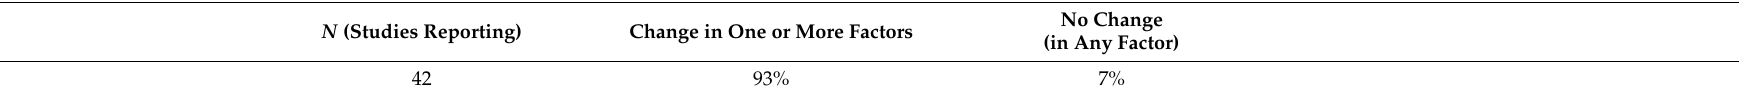
Table 3. Results of the meta-analysis of research studies ( N = 42) on the interactions of livelihood diversification with resource and ecological systems. This analysis drew from 42 published research papers that related the diversification of livelihood activities, with emphasis on migration, non-migration diversification of livelihoods, and the conditions of agrobiodiversity, soil and water resources, and uncultivated